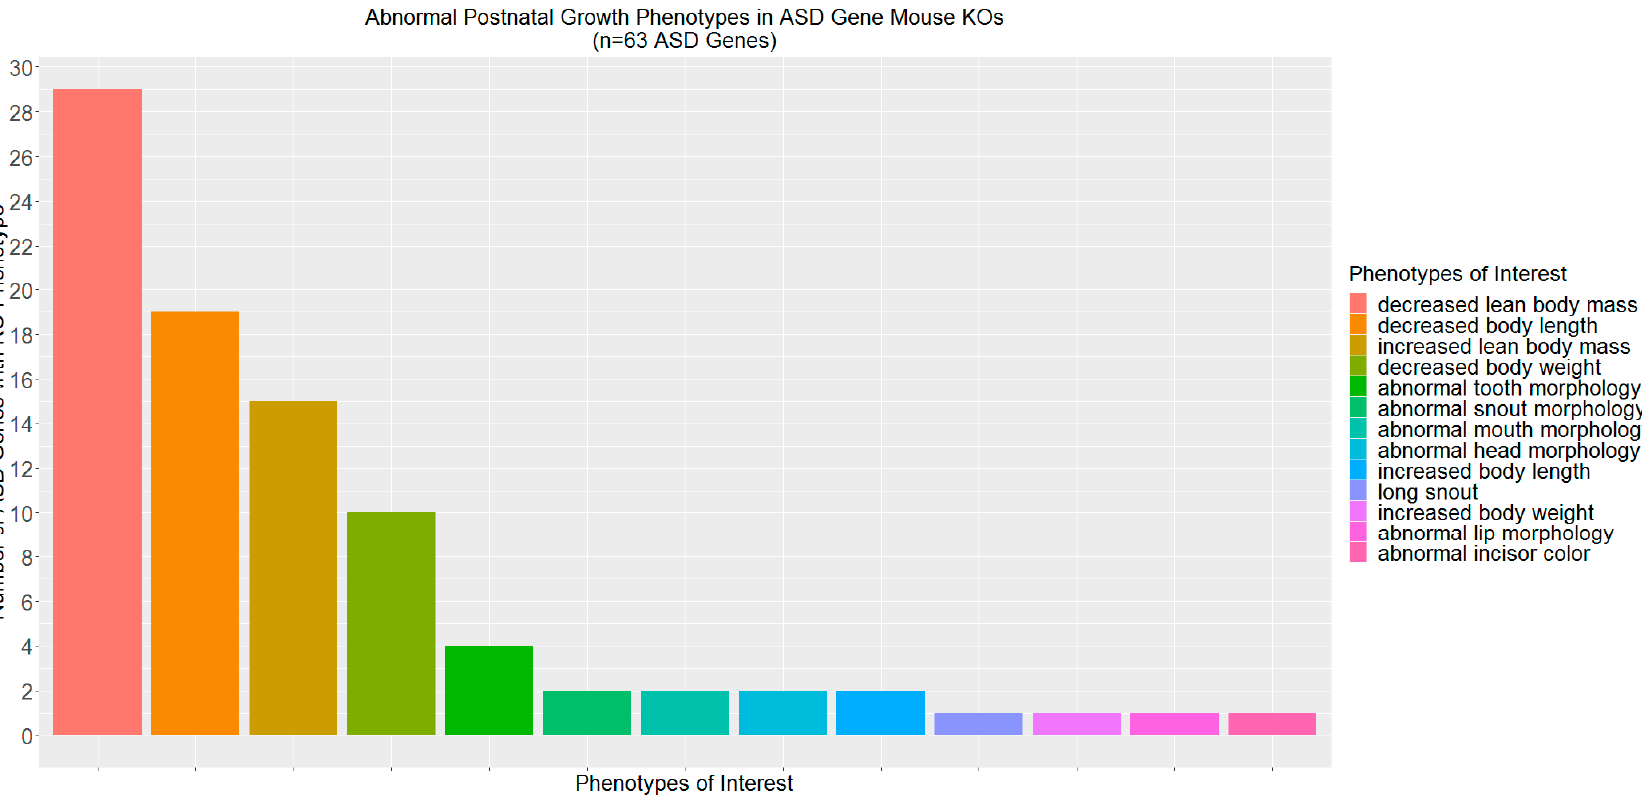
Figure 2. Frequency of Autism Spectrum Disorder-related Genes Associated with Abnormal Postnatal Growth Phenotypes. Shown are the specific traits that were associated more often with knocking out the 63 ASD candidate genes associated with growth phenotypes in mice (see Supplementary Table S1 for mouse trait associated genes) when compared to genes from random sets. Traits are presented in descending order based on the number of associated ASD genes.